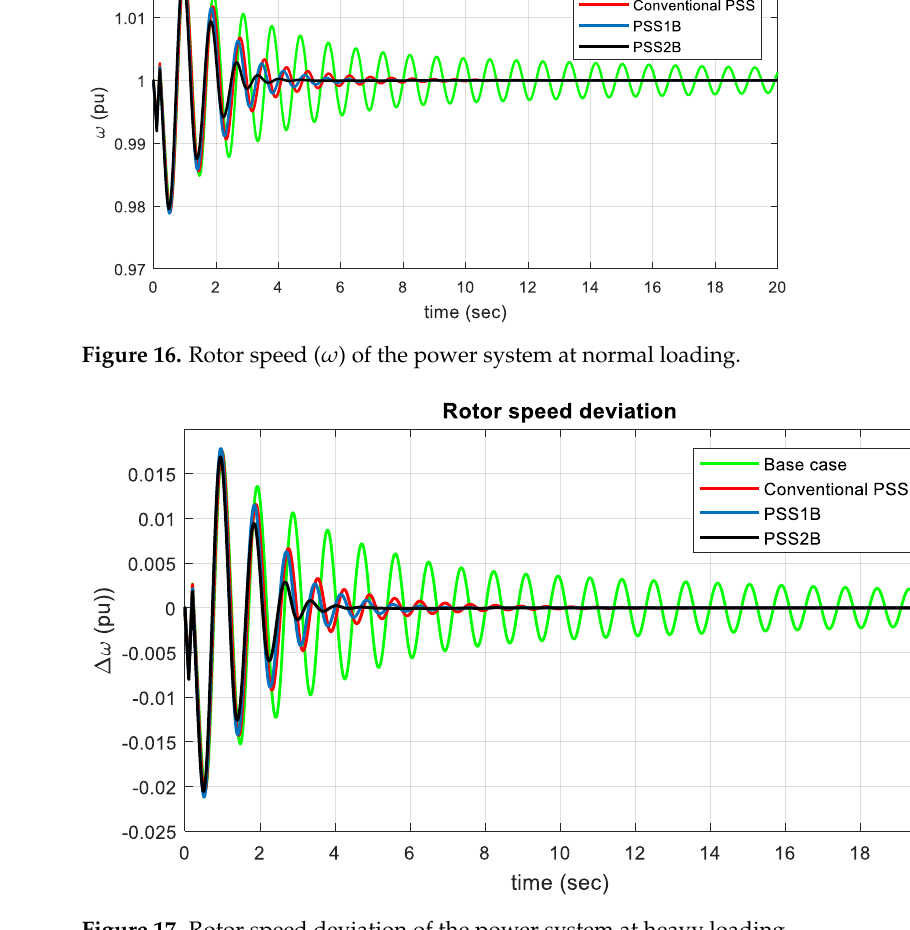
Figure 17. Rotor speed deviation of the power system at heavy loading.